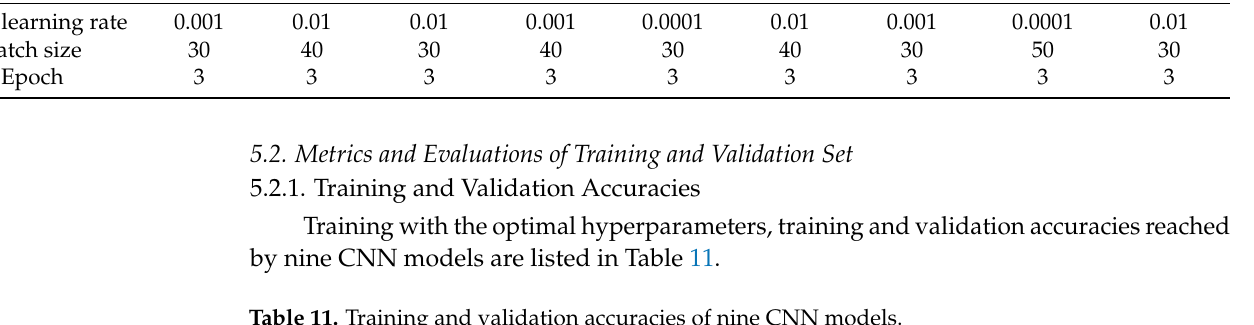
Table 11. Training and validation accuracies of nine CNN